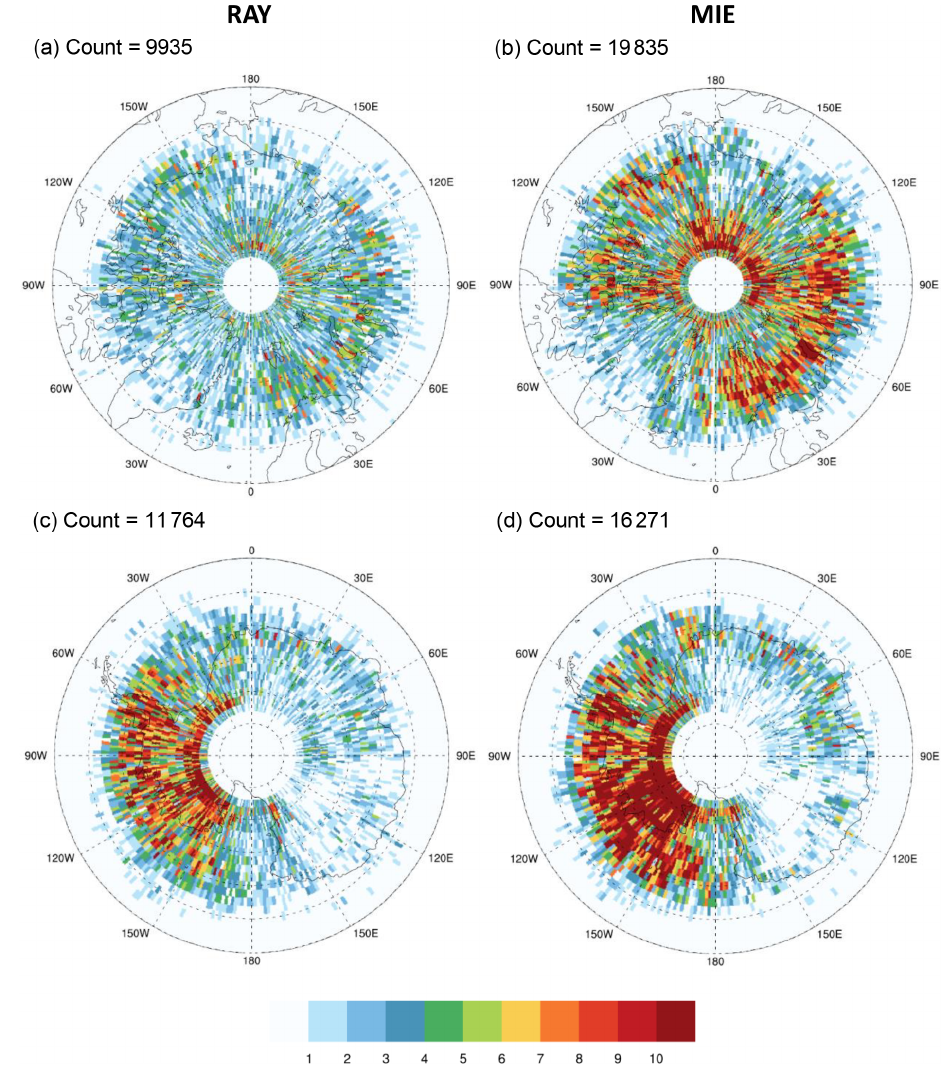
Figure 5. Number densities of IR-derived AMVs from all available LEO satellites co-located with Aeolus RAY (a, c) and MIE (b, d) winds in the (a, b) Arctic (north of 60 ◦ N) and (c, d) Antarctic (south of 60 ◦ S) are shown. Colors indicate total number of co-located observation pairs within a grid cell at 1.25 ◦ (approximately 140km in the N–S direction) horizontal resolution. Dashed latitude lines are spaced every 5 ◦ . The total observation count per panel is displayed in the top left